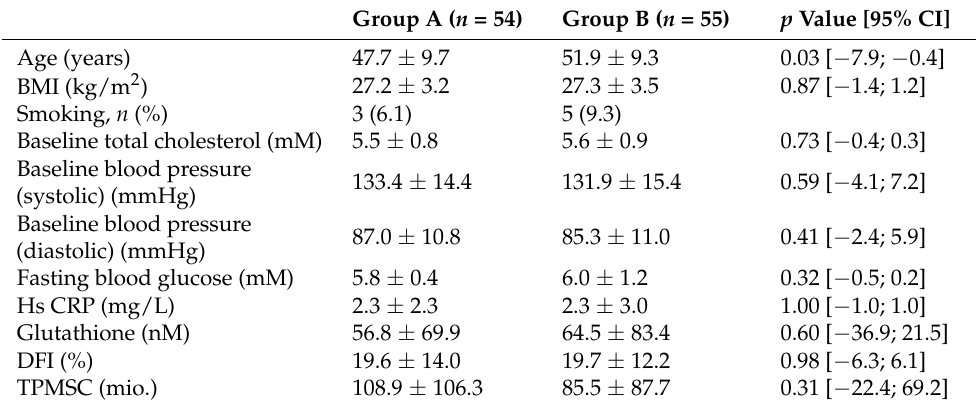
Table 1. Demographic data. Baseline values expressed as mean ± SD.